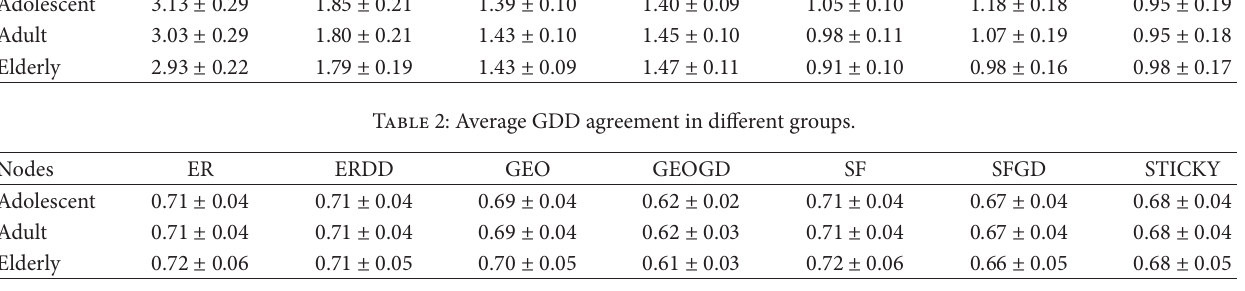
Table 3: Average Pearson correlation coefficients of degree distributions in different